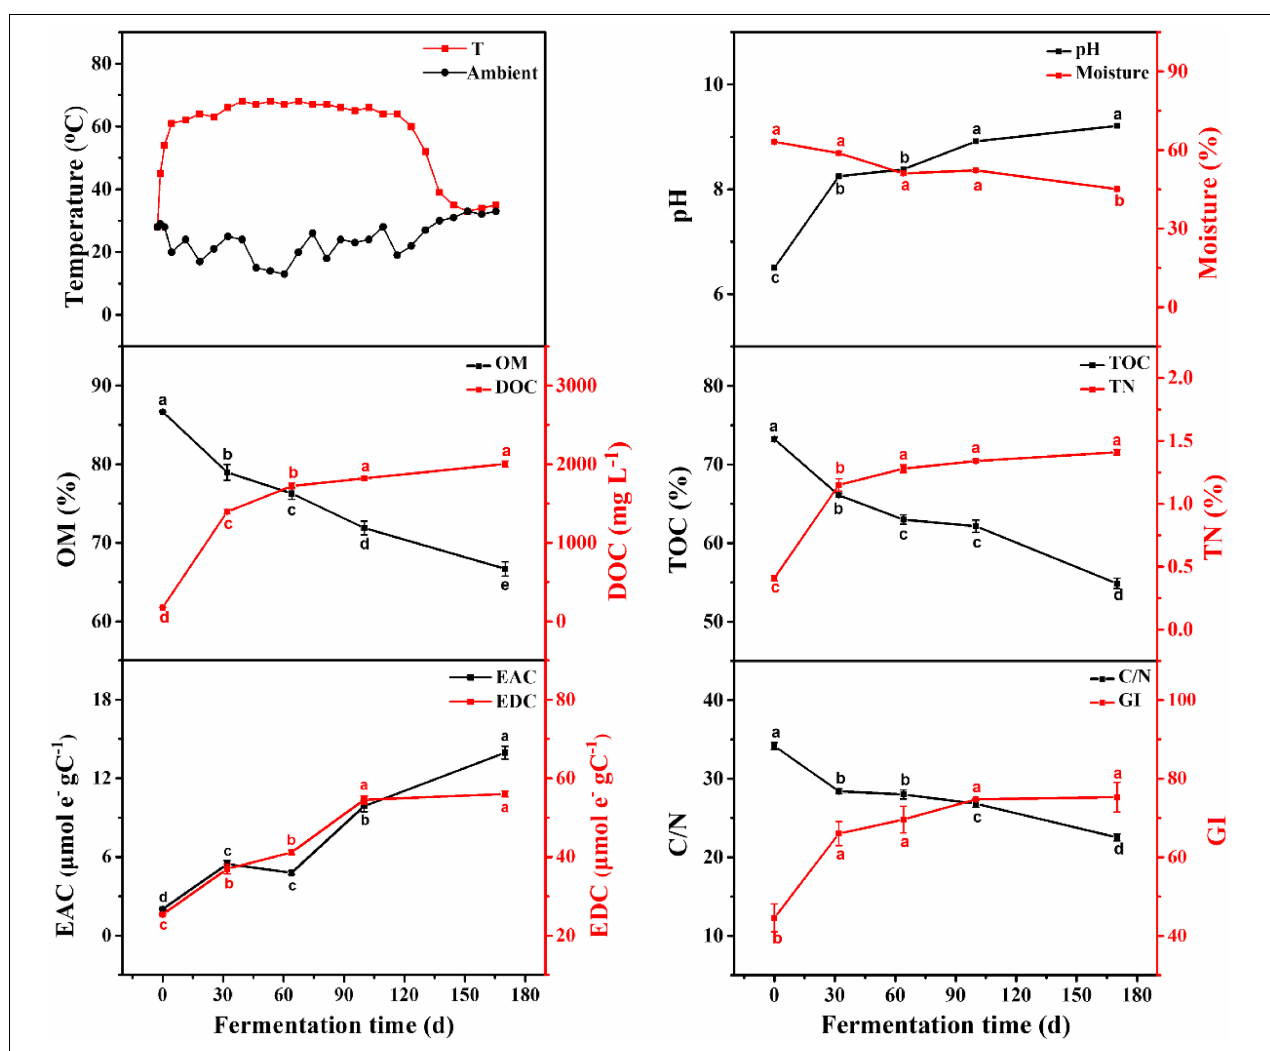
FIGURE 1 | Physico-chemical parameters of samples during ectopic fermentation systems (EFS). Line plots that do not share a letter are significantly different ( p <